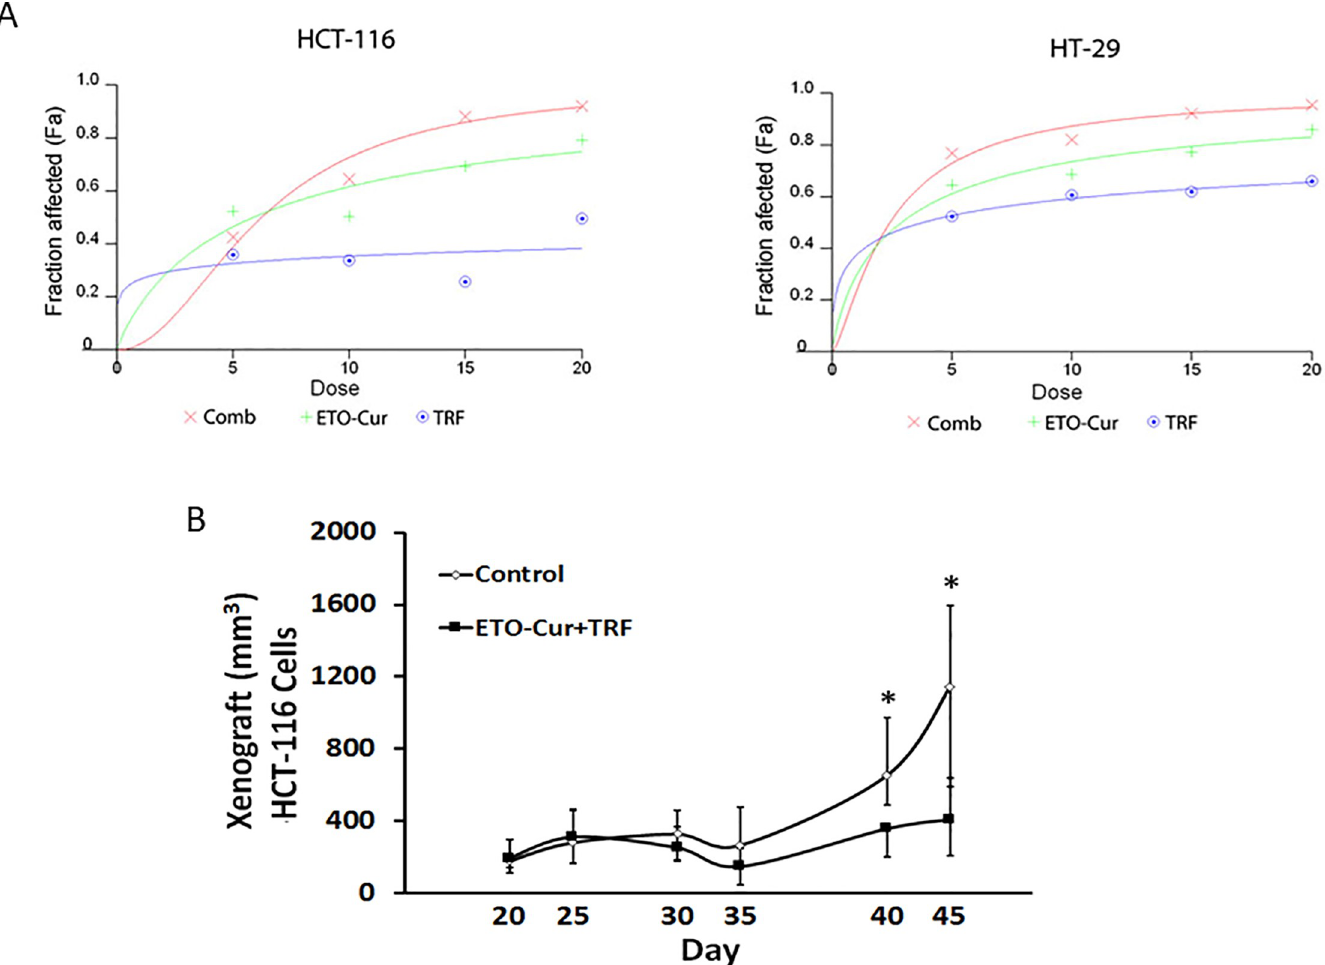
Fig 1. Dose response curves for ETO-Cur and TRF in HCT-116 and HT-29 cells produced by fixed ratio method (A). The cells were treated with increasing doses of ETO- Cur and TRF for 72 h in quadruplicate. MTT assay was performed to calculate viable and the affected cells. Fa represents the fraction of cells affected in response to the treatment. Fa for combination treatment was higher than either agent alone. Fa values were used to calculate synergy using CalcuSyn software as described in Materials and Methods. CI values < 0.9 suggest synergy. Tumor growth in SCID mice injected with HCT-116 cells (B). The mice were given a mixture of 5 mg/kg ETO-Cur and 2 mg/kg TRF five days a week by oral gavage in 100 μ l sesame oil for 6 weeks. Control animals were given sesame oil alone. Tumors were measured once a week and tumor volumes were calculated using the formula: Tumor volume = length x width x width/2. Each point represents average volume of 8 tumors ± standard deviation. � p value < 0 . 05 .